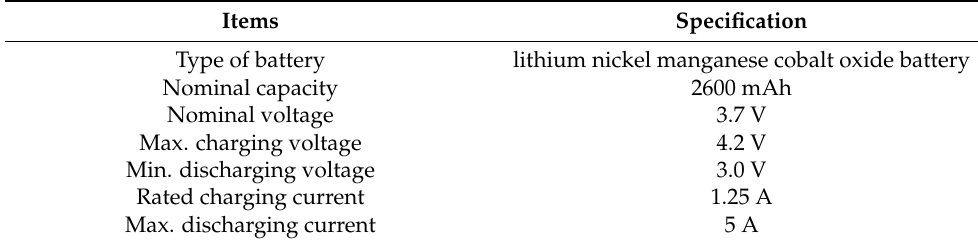
Table 1. Specification of the lithium-ion battery UR18650ZY.